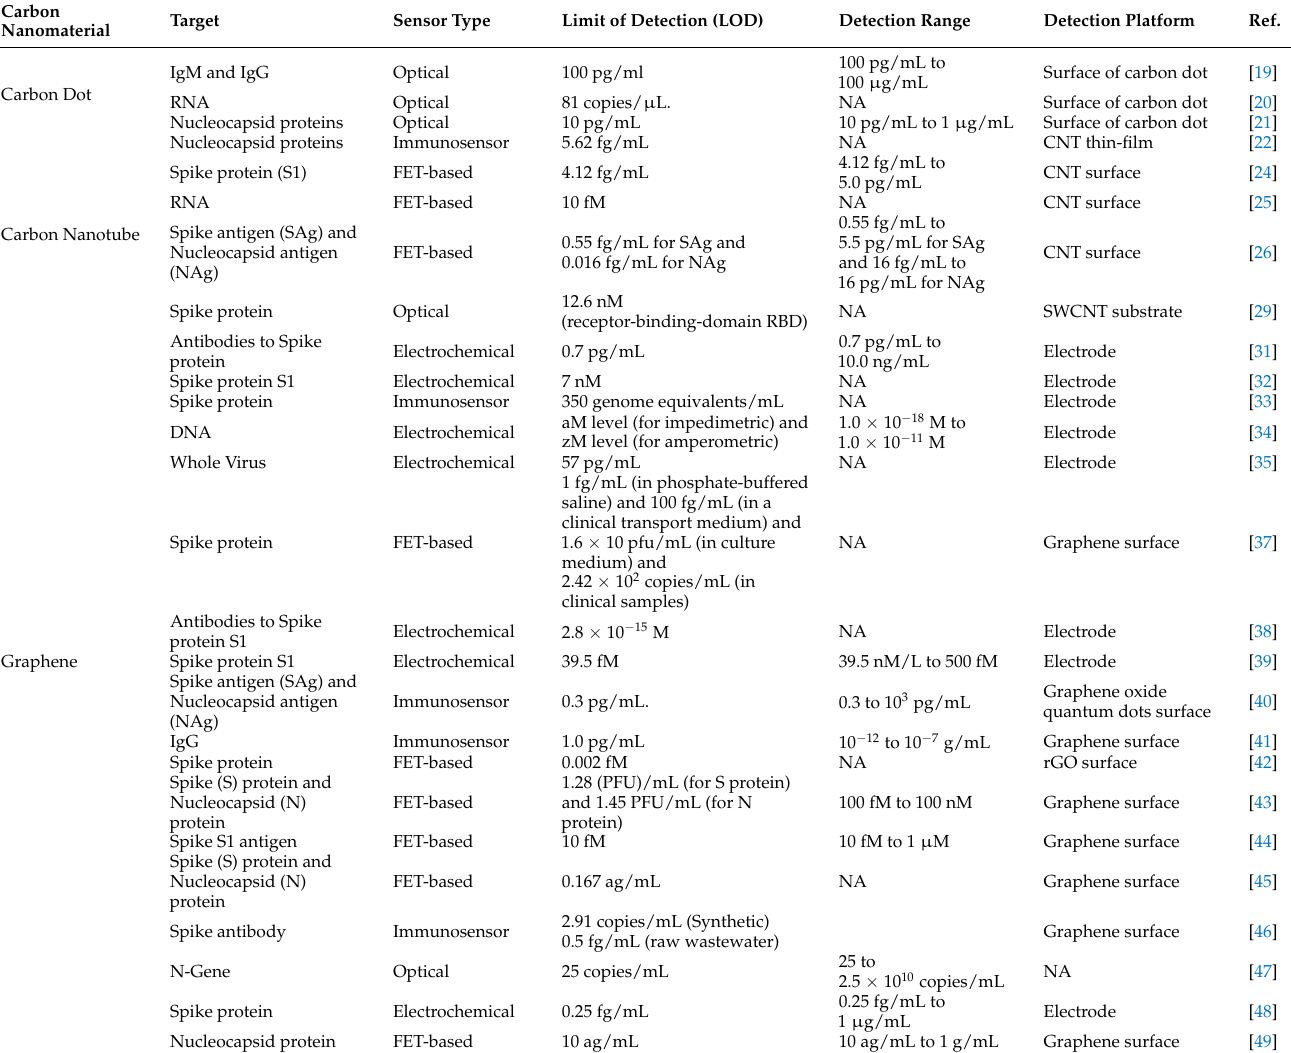
Table 1. Carbon nanomaterials-based biosensors to identify the SARS-CoV-2